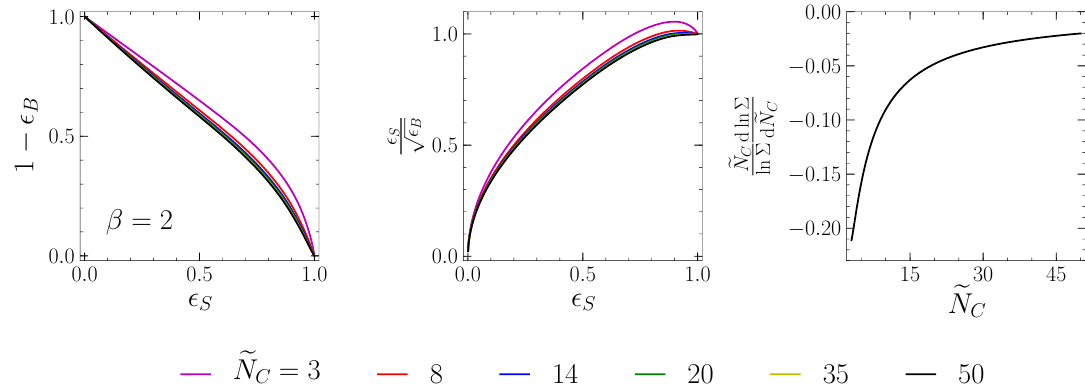
Figure 6 . Discrimination of dark sector against QCD for various choices of the number of colors in the dark sector e N C for p T = 1 TeV jets, using the MLL analytic calculation. Note that the impact of errors is ignored here, see section 2.4 for details. We show ROC curves in the background rejection 1 (cid:15) B versus signal efficiency (cid:15) S plane [left]. We show the curve of discriminatory significance (cid:0) (cid:15) S = p (cid:15) B against signal efficiency (cid:15) S [middle]. Fixing the background rejection at 90 % , we then show the relative change in discriminatory power as a function of e N C . The angular dependence parameter is (cid:12) = 2 for all